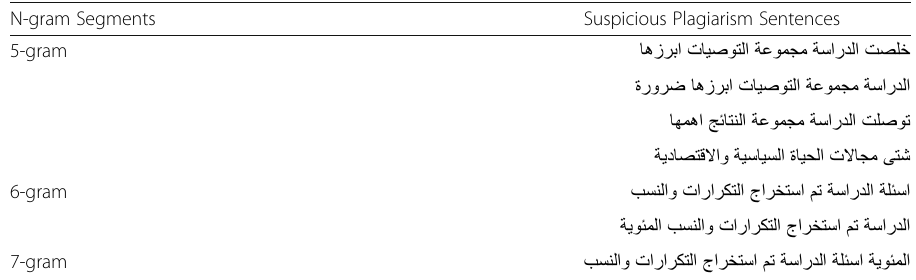
Table 19 Samples of plagiarized n-gram